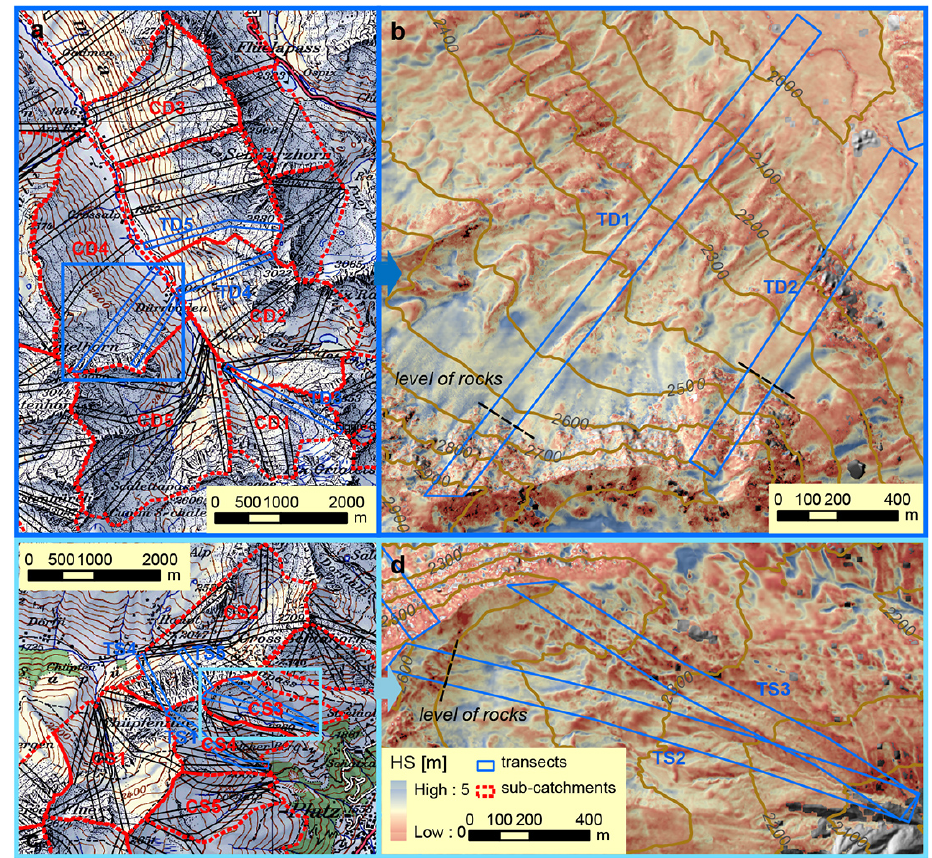
Figure 3. Detailed maps of catchment (CD1–5 and CS1–5 see Fig. 6), and transects (CT1–5 and CS 1–5 see Fig. 7) and discussed in the text. Maps reproduced with permission (Swisstopo,